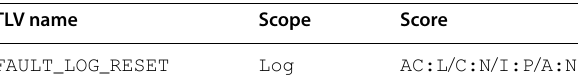
Table 5 PTP IEEE-1588 2008 TLVs that can be used to cover tracks of a PTP